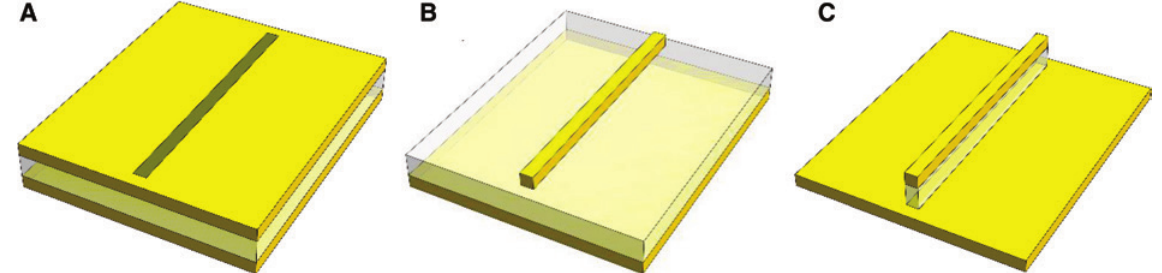
Figure 17: Principle perfect absorber